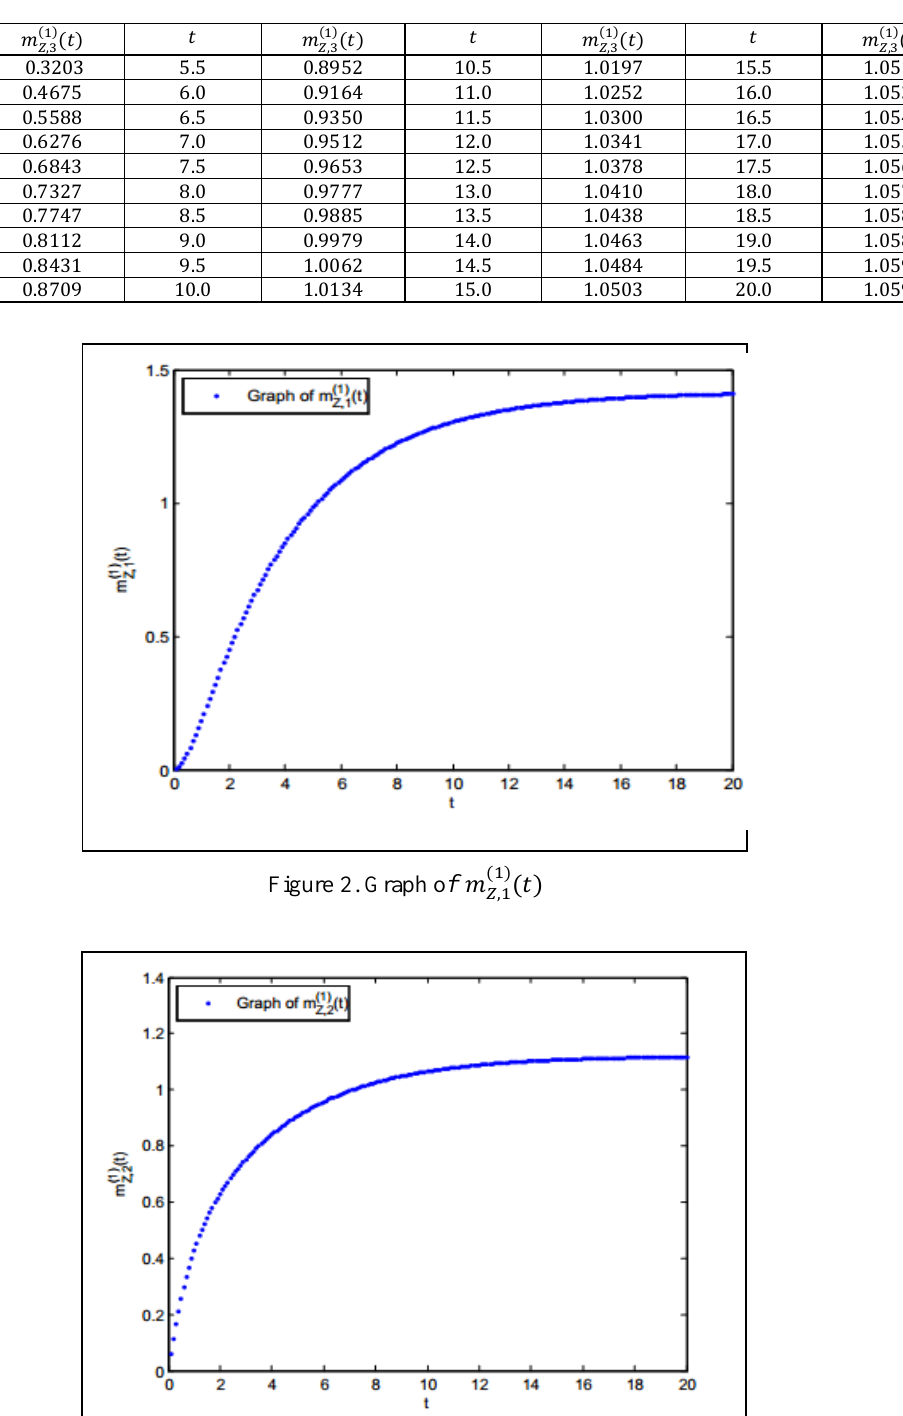
Table 3. Environment level 3 dependent growth of maligant cells (One mutation)